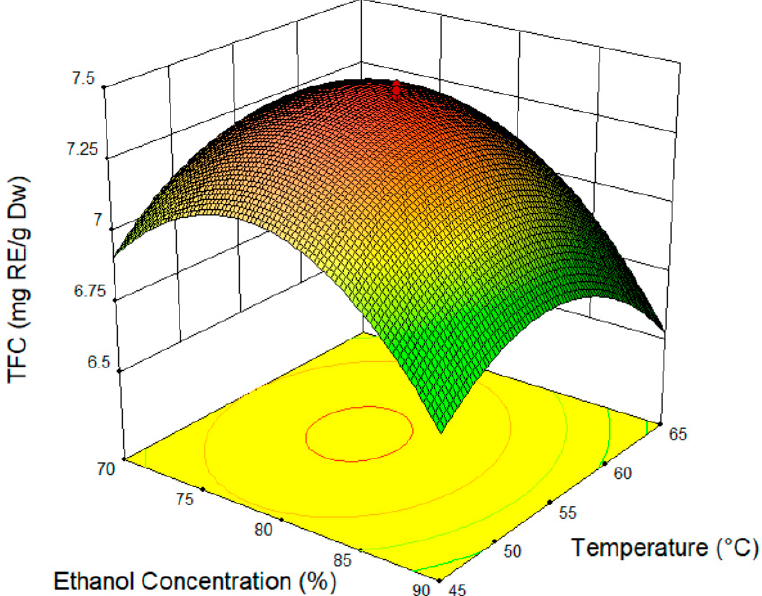
Figure 1. Response surface plot and of ethanol concentration (X 1 ) and temperature (X 2 ).